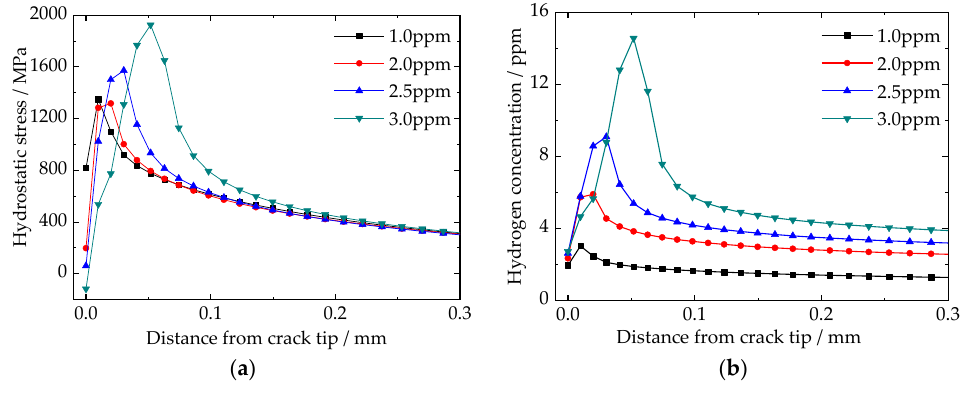
Figure 8. Distributions of hydrostatic stress and hydrogen content around crack tip: ( a ) hydrostatic stress; ( b ) hydrogen content.